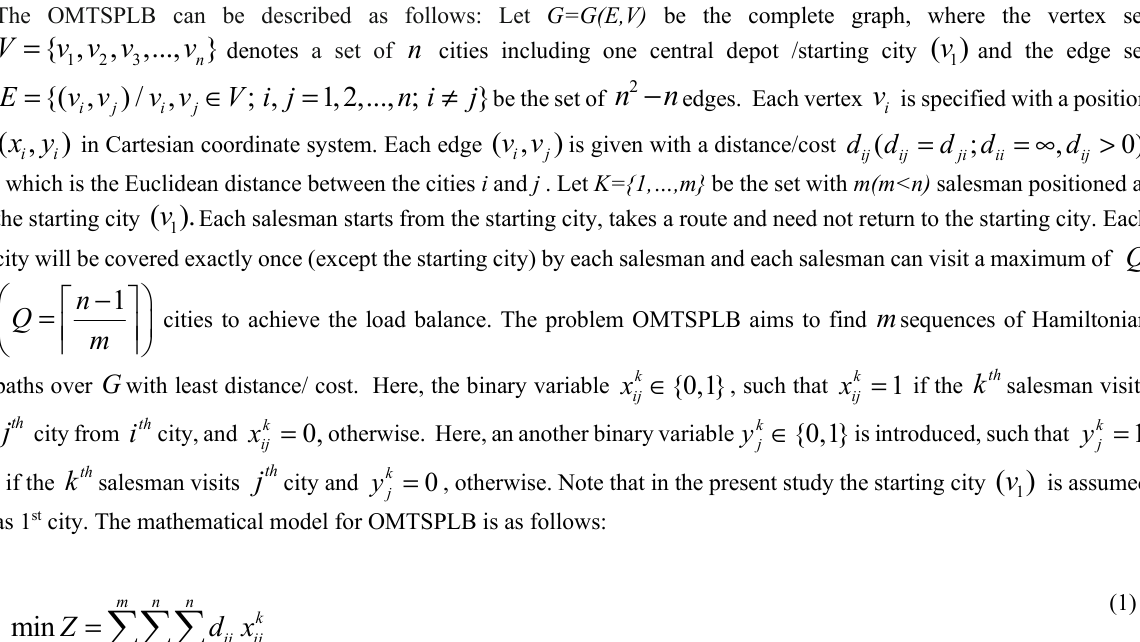
Fig 2. An example solution of OMTSP with load